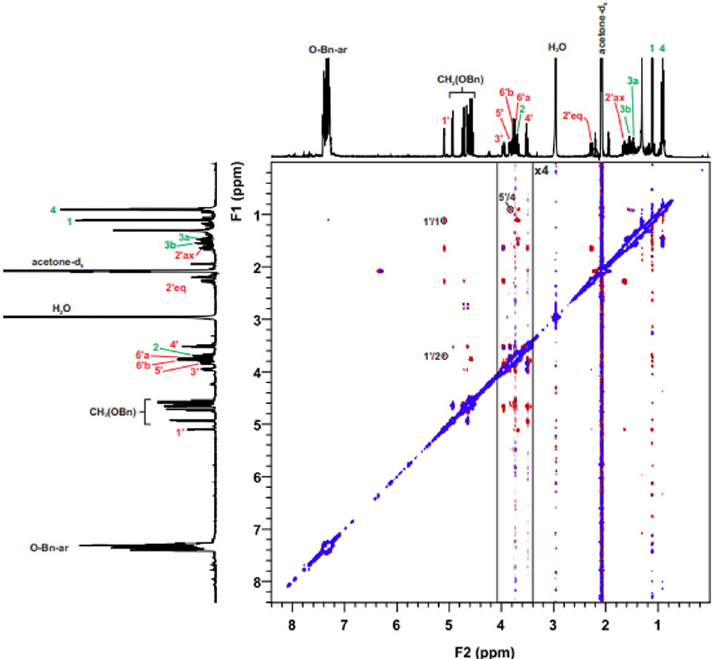
Figure 10. ROESY spectrum of molecule 2C with all dipole couplings (diagnostic signals are marked in a circle).